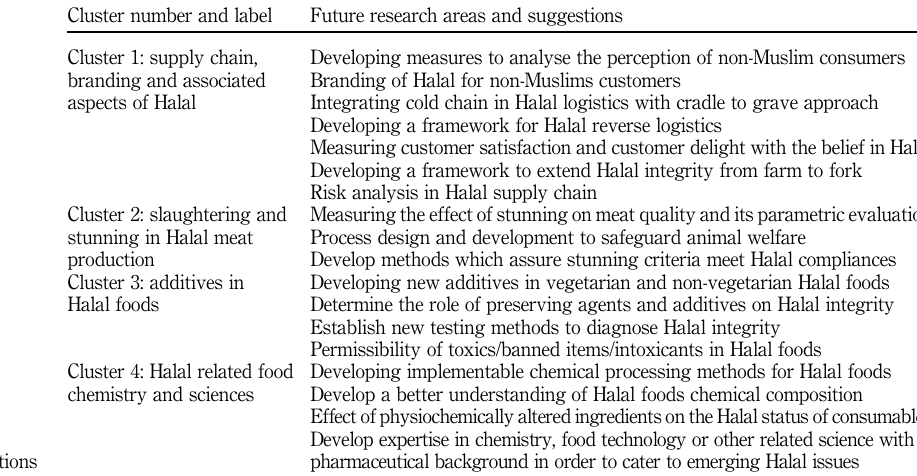
corresponding research